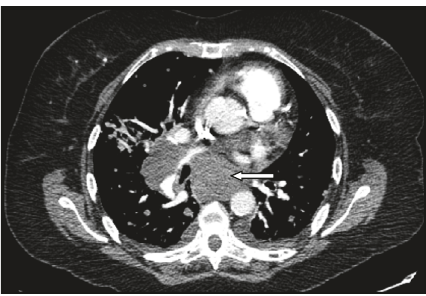
Figure 1: Preoperative computed tomography (CT) scan. This CT demonstrates large mediastinal and hilar lymph nodes with the largest being located in station VII (subcarinal nodes) with a 5.6 cm diameter (arrow) resulting in a mass effect on the bronchus and hilar vessels.